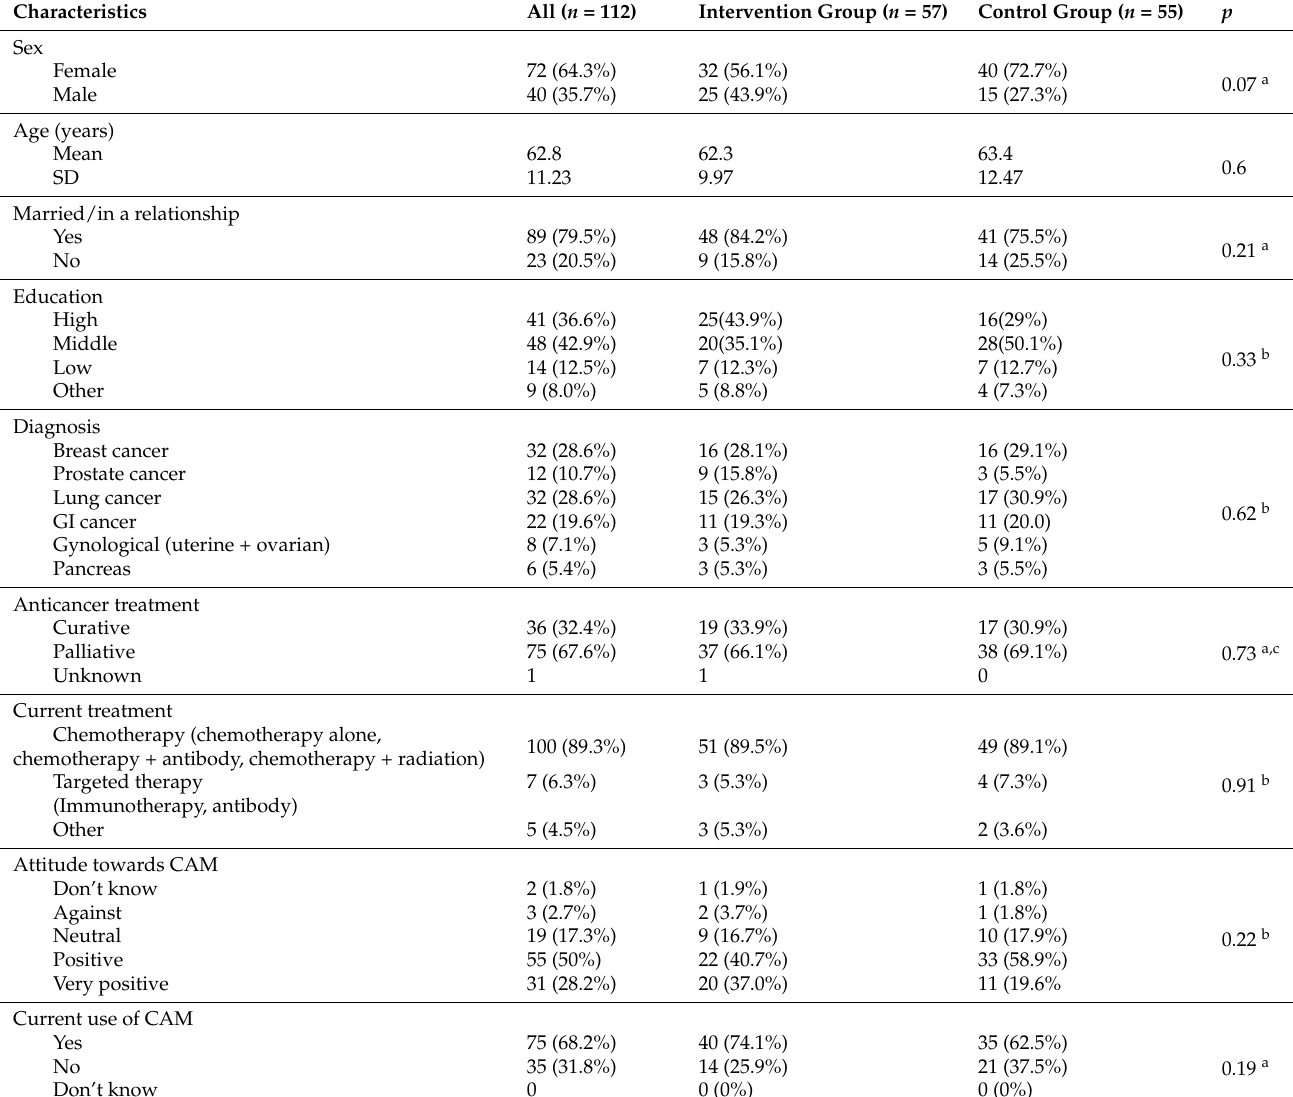
Table 2. Baseline Sociodemographic and Clinical Characteristics ( n =